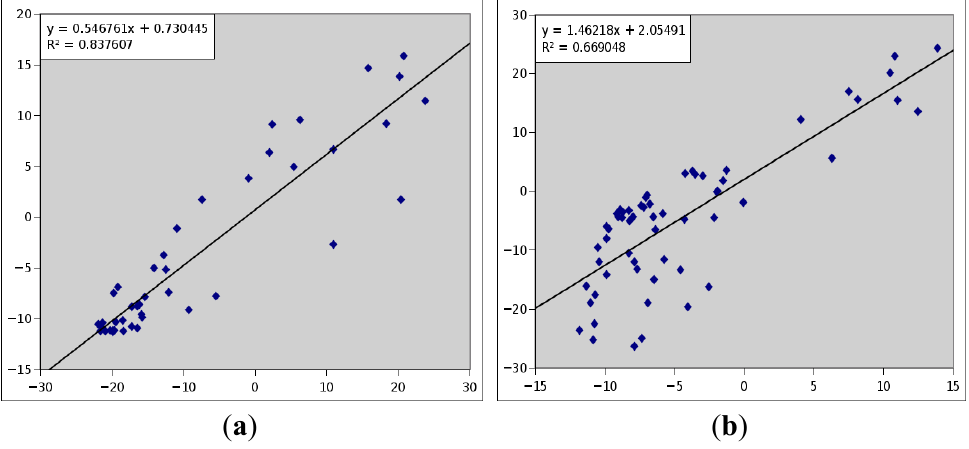
Figure 10. Correlation plot for the RDC data from 1P7E ( a ) and 1D3Z ( b ) in two alignment